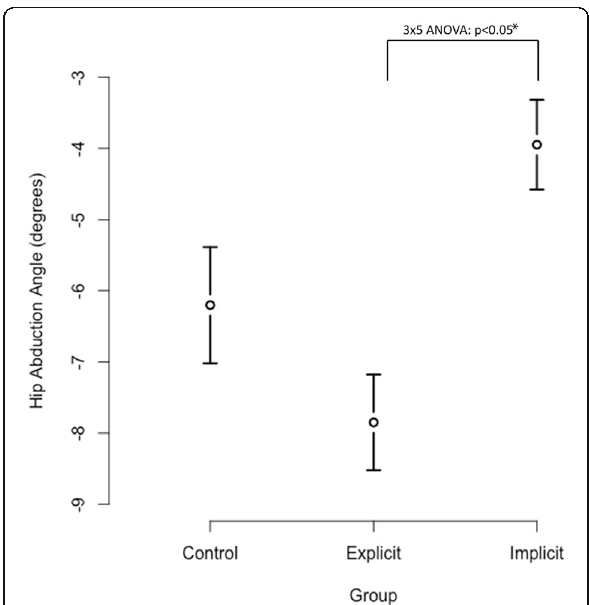
Fig. 2 Visual depiction of group main effect for peak hip abduction angle of mean±2 standard deviations. Statistically significant difference between explicit and implicit groups, where implicit group is closer to neutral